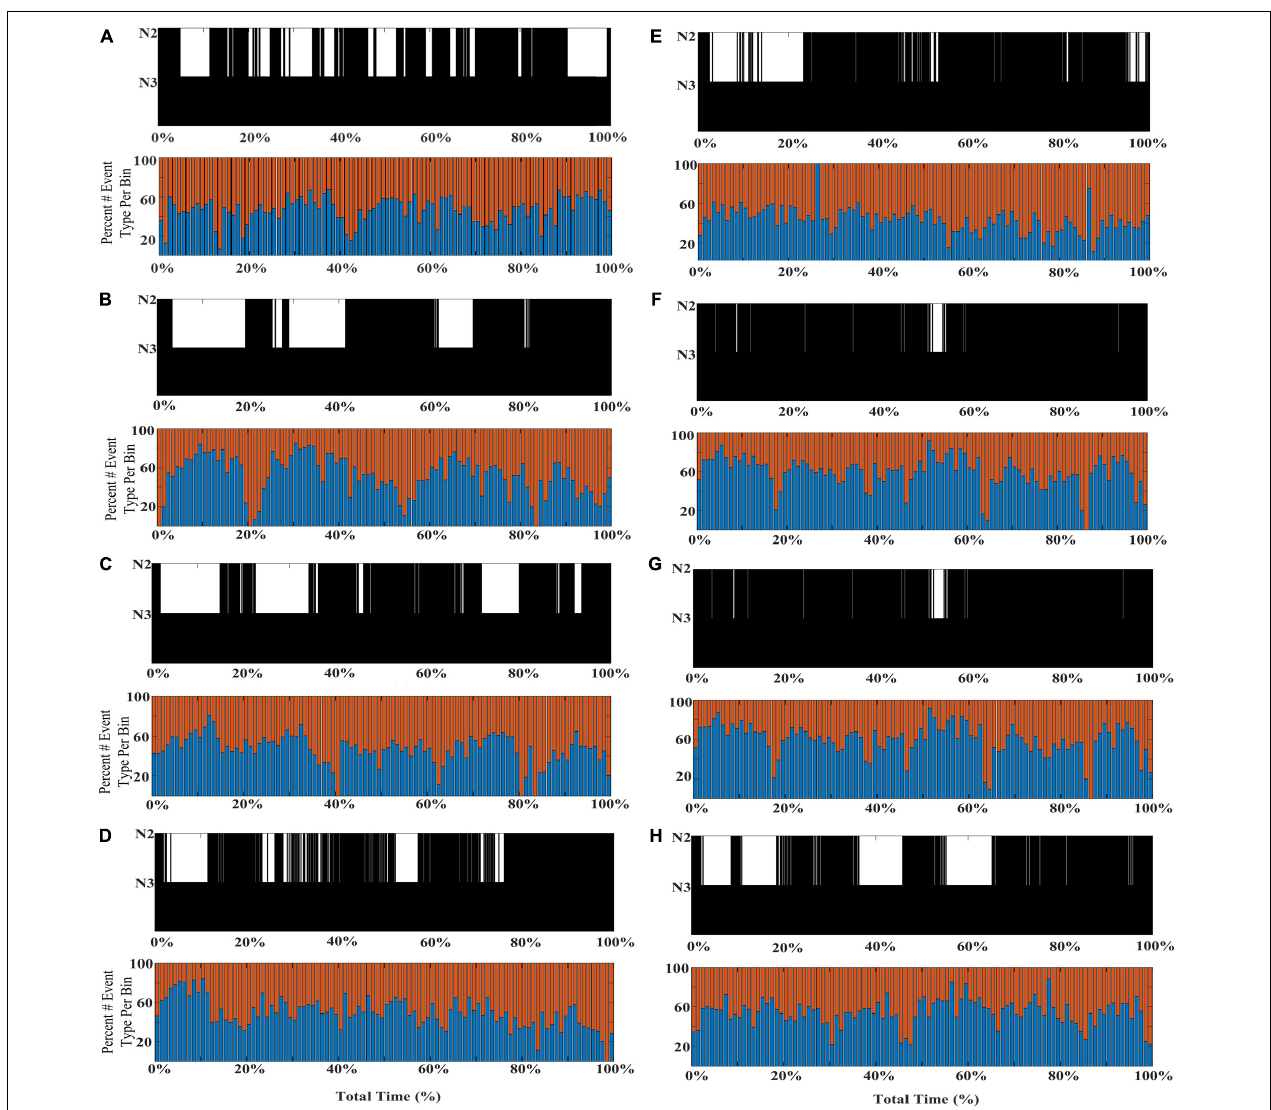
FIGURE 5 | Individual differences in the shifting composition through stages N2 and N3 SWA. Event histograms marking the percentage of early-fast spindle/slow waves detected in channel CZ (red bars) and late-fast spindle/slow waves detected in channel FP1 (blue bars) are graphed in time bins of 2 min [ (A–H) ; DREAMS Subjects 1, 2,